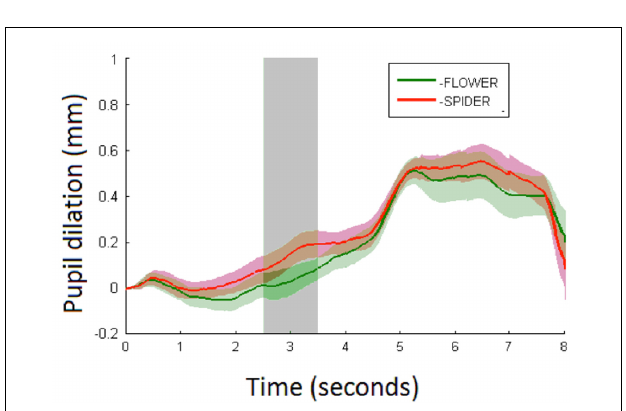
FIGURE 3 | Average pupil dilation (mm) for spiders (red) and flowers (green) over 8 s with shaded areas showing the standard errors. Stimulus onset is at 0 s with a duration of 5 s at which a white screen onsets. The analysis time period is marked in light